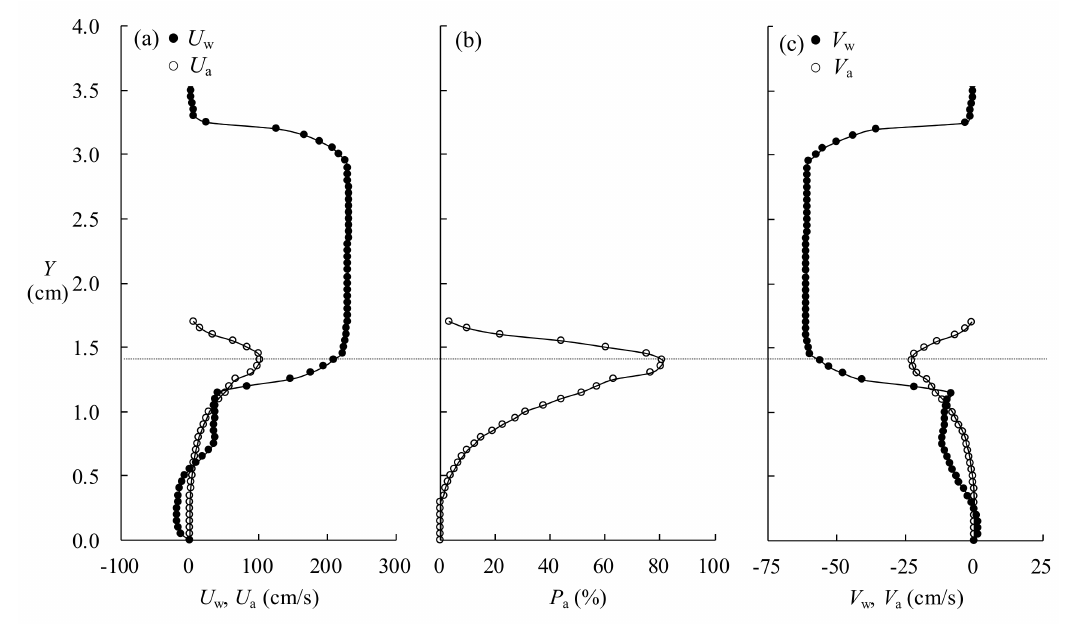
Figure 24. Relationship among ( a ) the profiles of mean streamwise velocities of both water stream and air-bubble phases; ( b ) the probability distribution for intermittent occurrence of air bubbles, and ( c ) the profiles of mean transverse velocities of both phases at X = 13.4